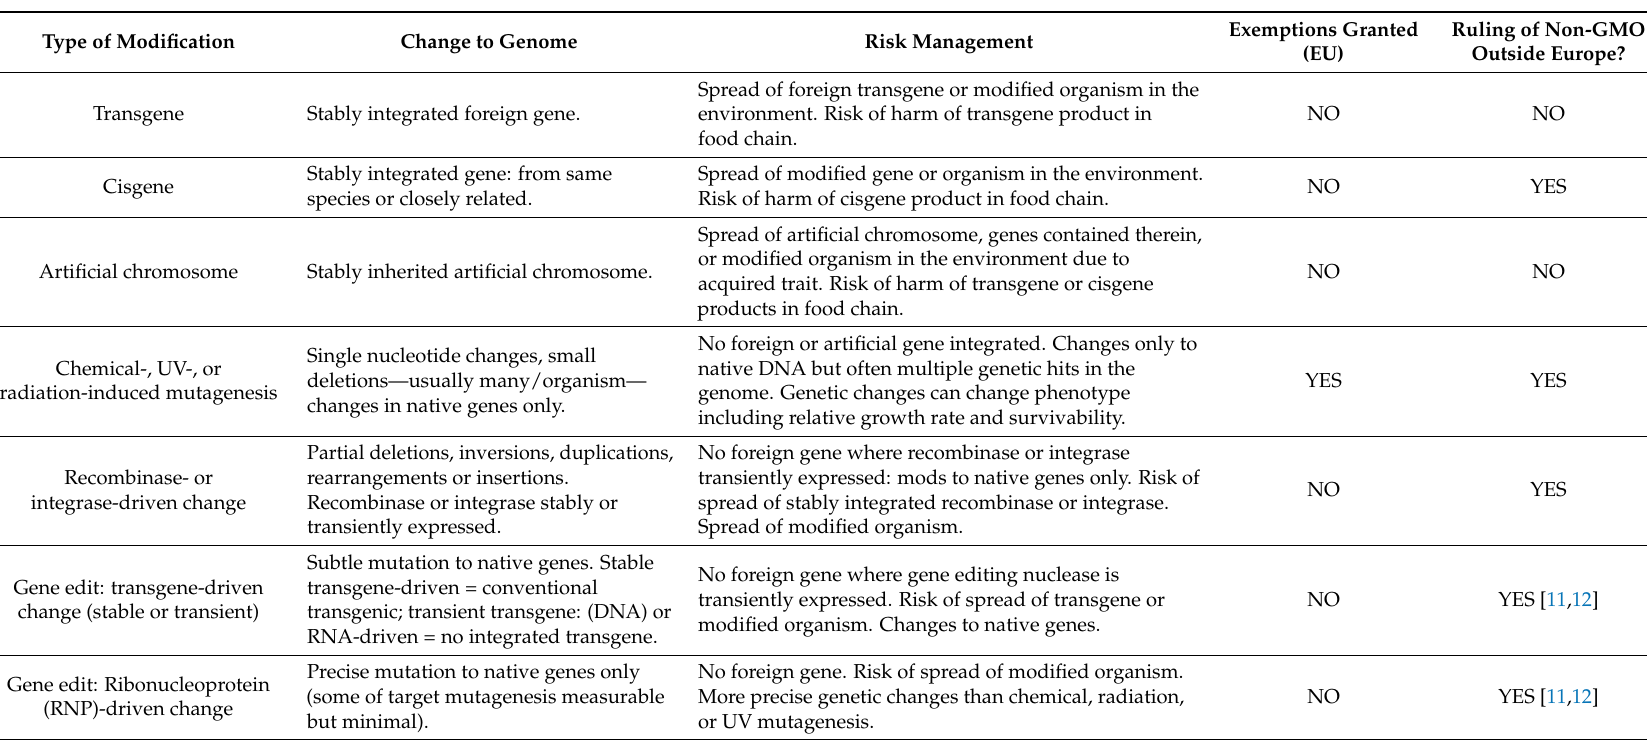
Table 1. What is a genetically modified organism (GMO)? Types of modifications in broad terms, the nature of the change to the genome, risk management considerations, exemptions that might be granted with regard to classification as GMO or not in the EU, and any rulings of non-GMO from outside Europe are